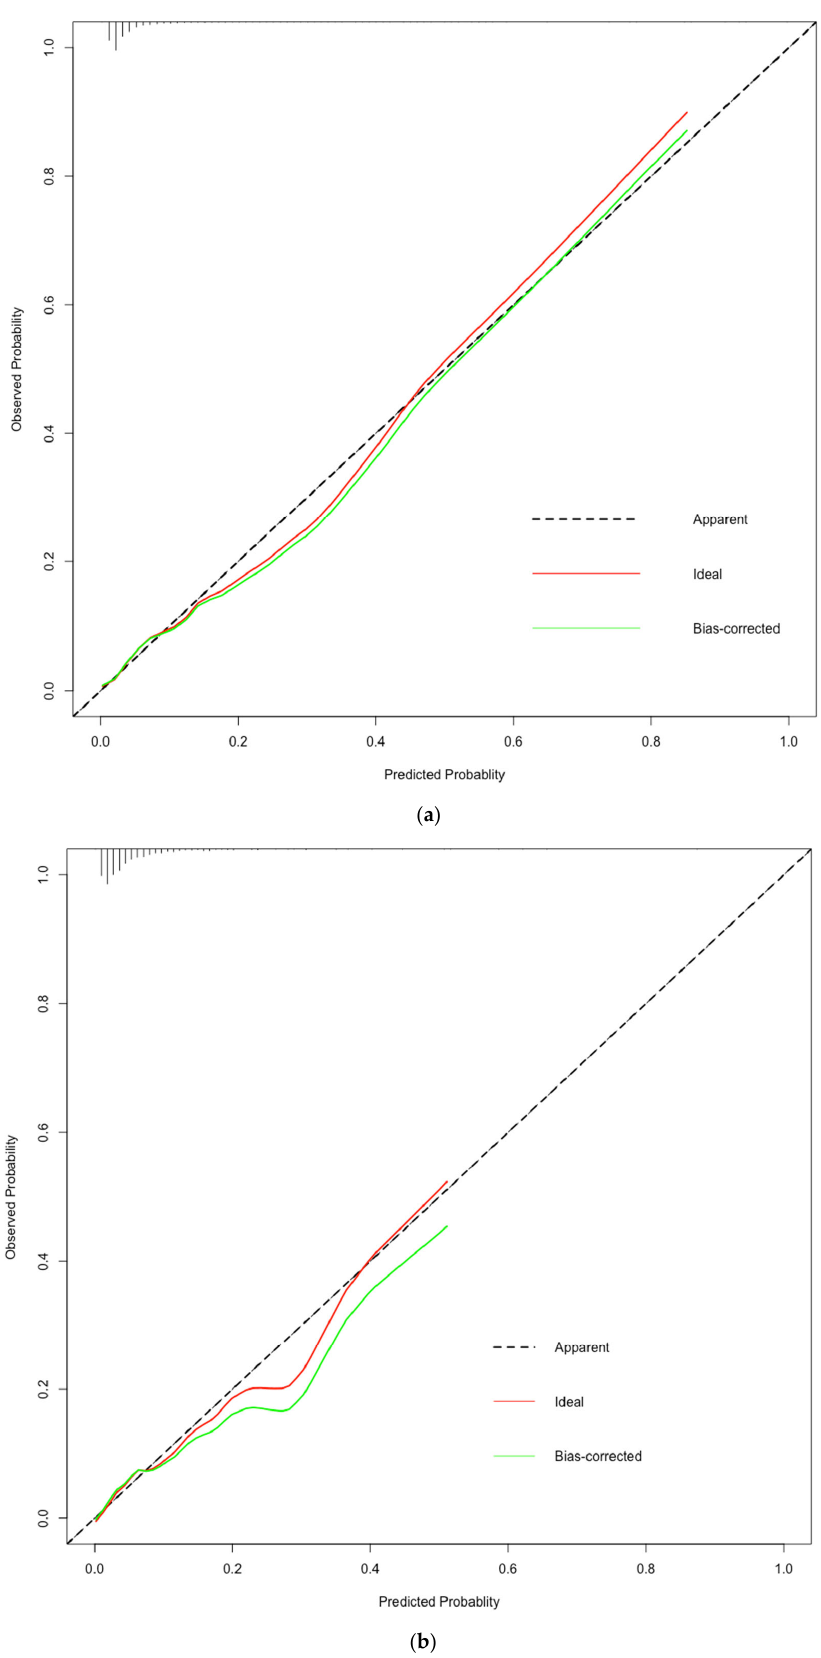
Figure 5. ( a ) Calibration curve of LASSO ‐ logistic regression and the EuroSCORE II in training cohort. ( b ) Calibration curve of LASSO ‐ logistic regression and the EuroSCORE II in testing cohort. In the testing sample, the AUC of this model was 0.739 (95% CI:0.673–0.805) (Figure 4b). The Hosmer–Lemeshow χ 2 was 6.64, p value was 0.576 and the calibration curve of the prediction model was close to the standard curve (Figure 5b). The AUC of the